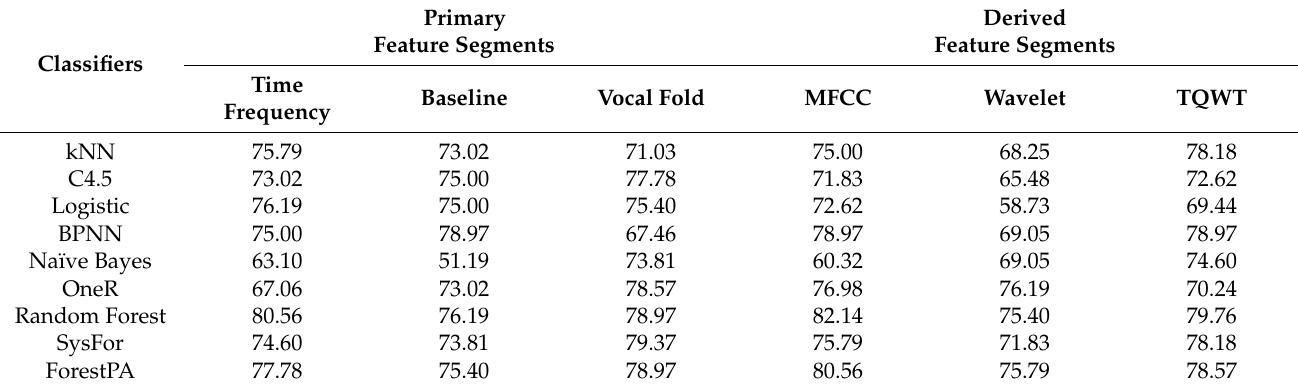
Table 2. The detection accuracy of supervised classifiers on each feature segments of Istanbul acoustic